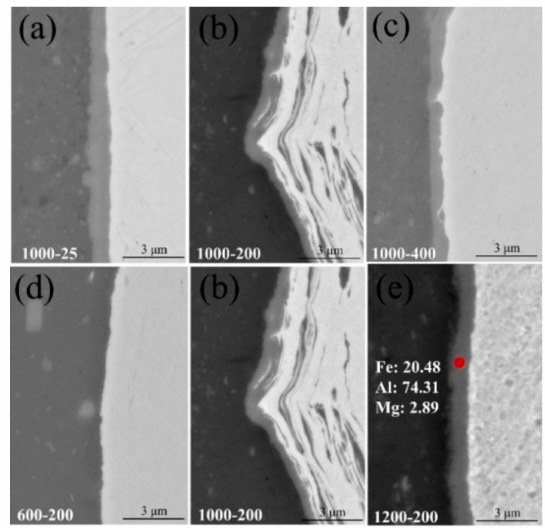
Figure 13. The variation of IMC thickness at the interface with different welding parameters. ( a ) 1000 rpm, 25 mm/min; ( b ) 1000 rpm, 200 mm/min; ( c ) 1000 rpm, 400 mm/min; ( d ) 600 rpm, 200 mm/min; and ( e ) 1200 rpm, 200 mm/min.